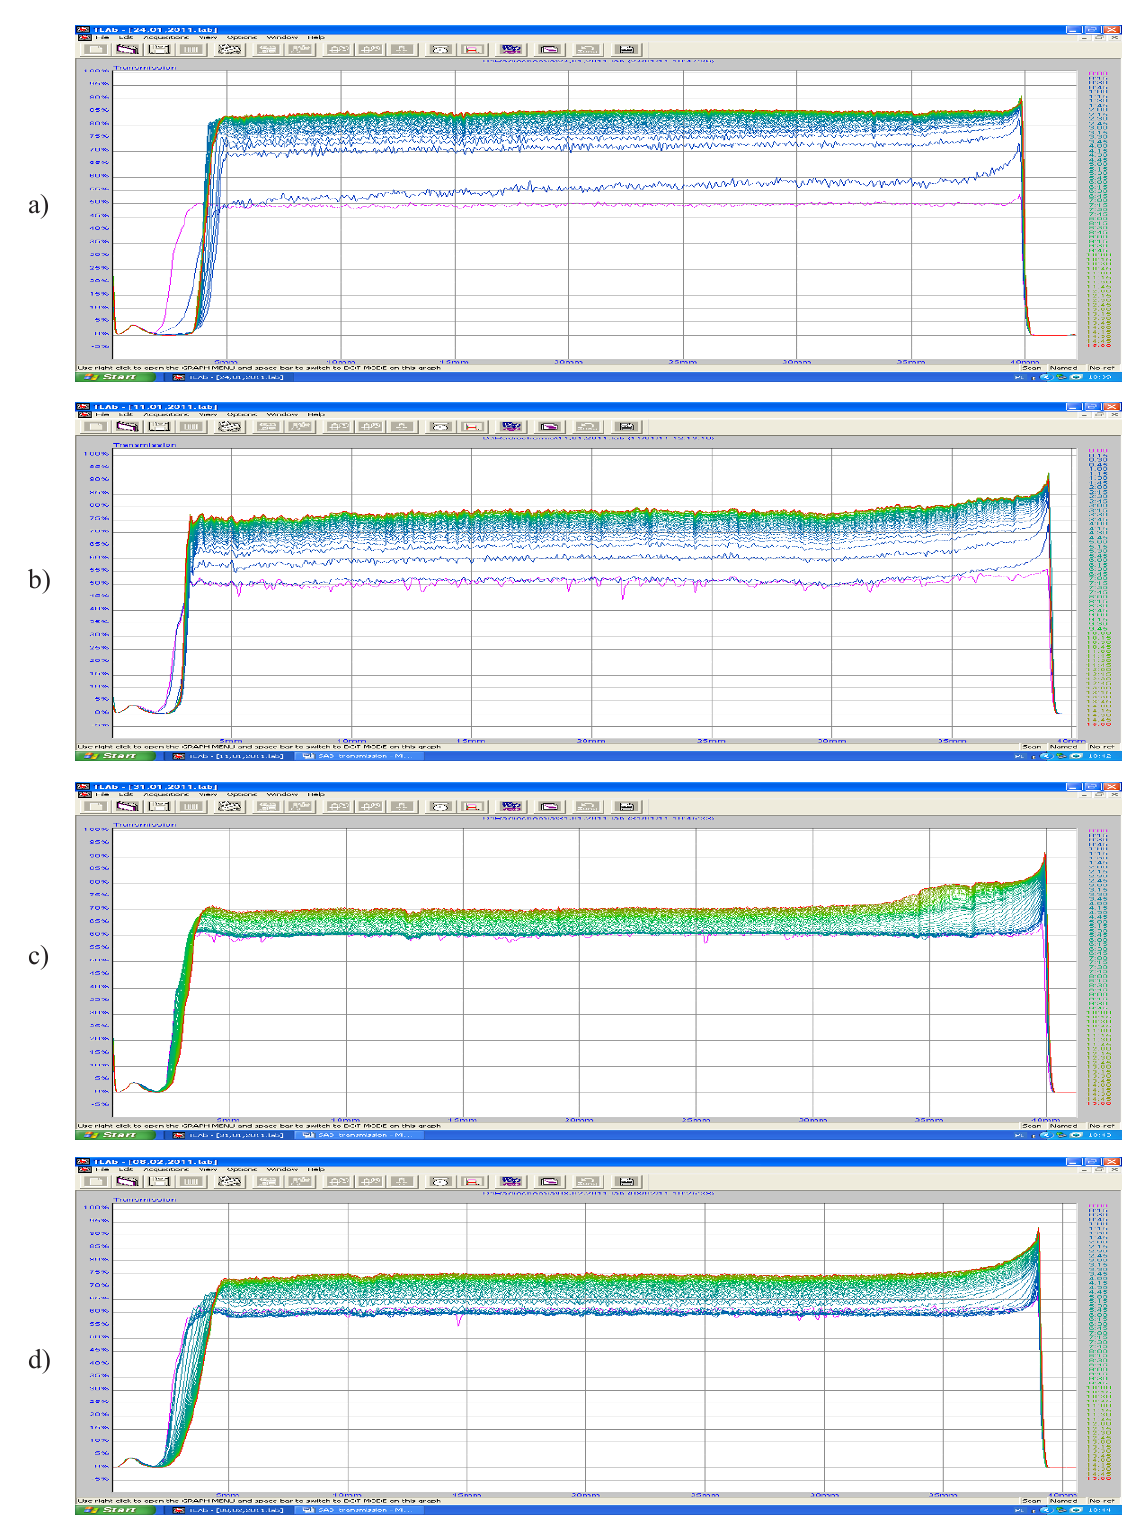
Figure 1. Transmission curves for systems: a) SA 3/NaCl, b) SA 3/NaCl/PAA 2000, c) SA 3/NaCl/PAA 100000, d) SA 3/NaCl/PAA 240000 at pH=3. The level of suspension in the measurement vial [mm] is along the x axis and the light intensity transmitted through the suspension [%] is along the y